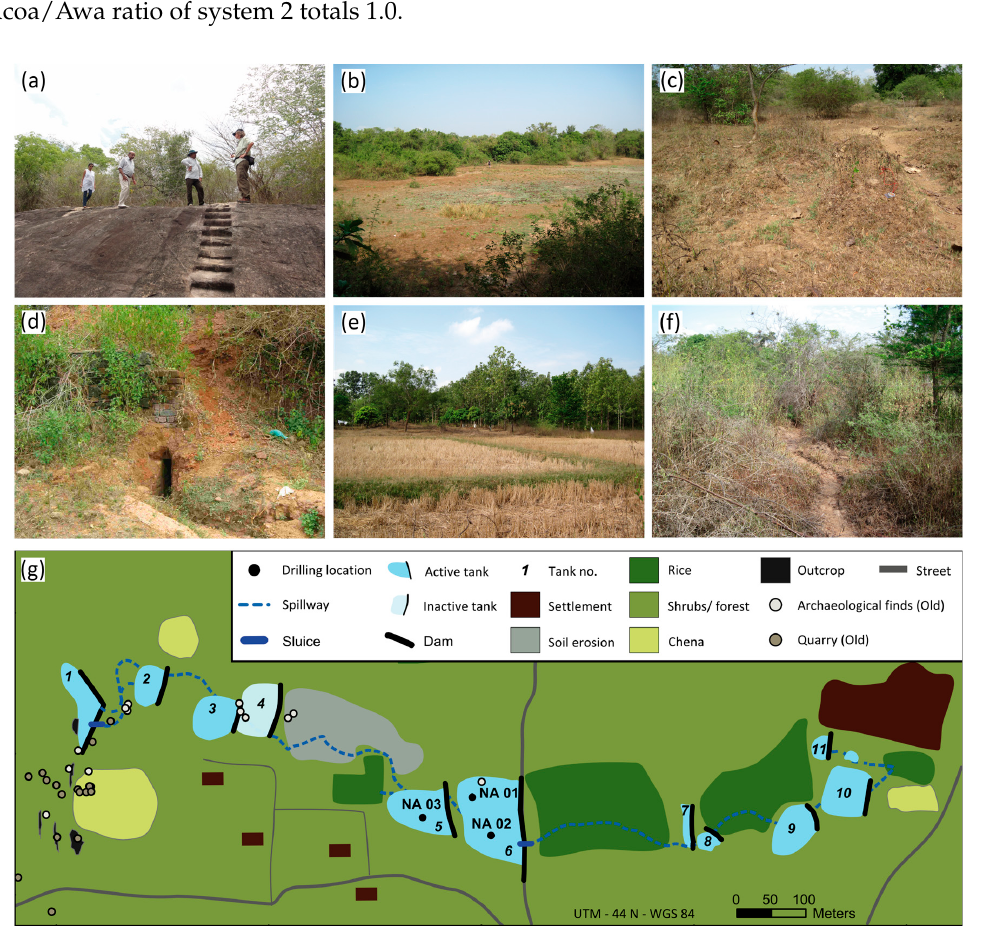
Figure 3. Detailed set-up and characteristics of system 2: ( a ) bedrock outcrop, with sculptured stairs as the western boundary of tank 1; ( b ) view from the dam of tank 6 into the desiccated water-spread area; ( c ) area affected by soil erosion; ( d ) sluice of tank 6; ( e ) paddy field between tank 6 and tank 7; ( f ) shallow earthen spillway connecting tank 4 and tank 5 surrounded by scrubland; ( g ) detailed layout of system 2, showing the bedrock outcrops in the headwater area, distribution of archaeological findings and the location of sediment profiles NA01-NA03.